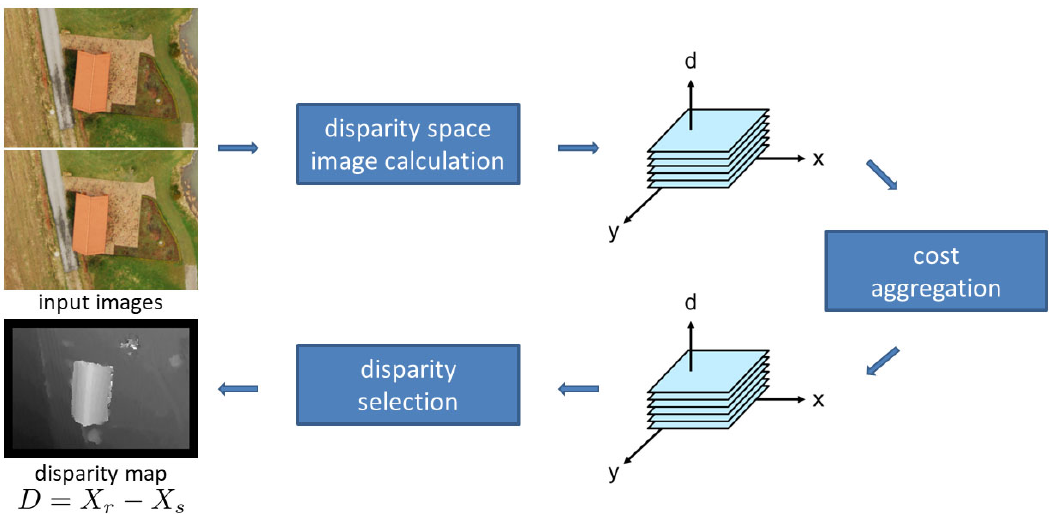
Figure 9. Image matching principle with epipolar rectified input images. The main steps are calculation of the disparity space image, cost aggregation and disparity selection. The final disparity map D holds the shifts in column directions for each pixel such that they point from the reference image X r to the search image X s